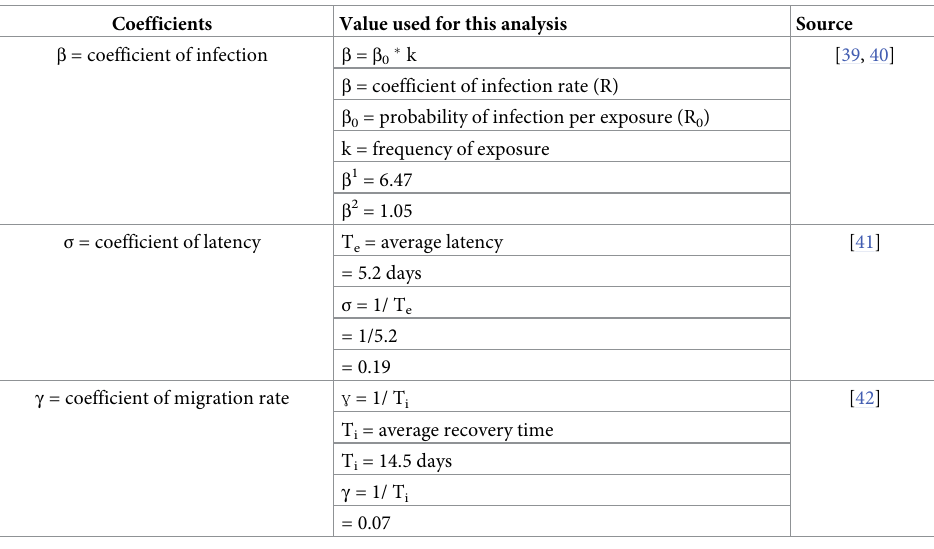
Table 2. SEIR parameters initialisation.